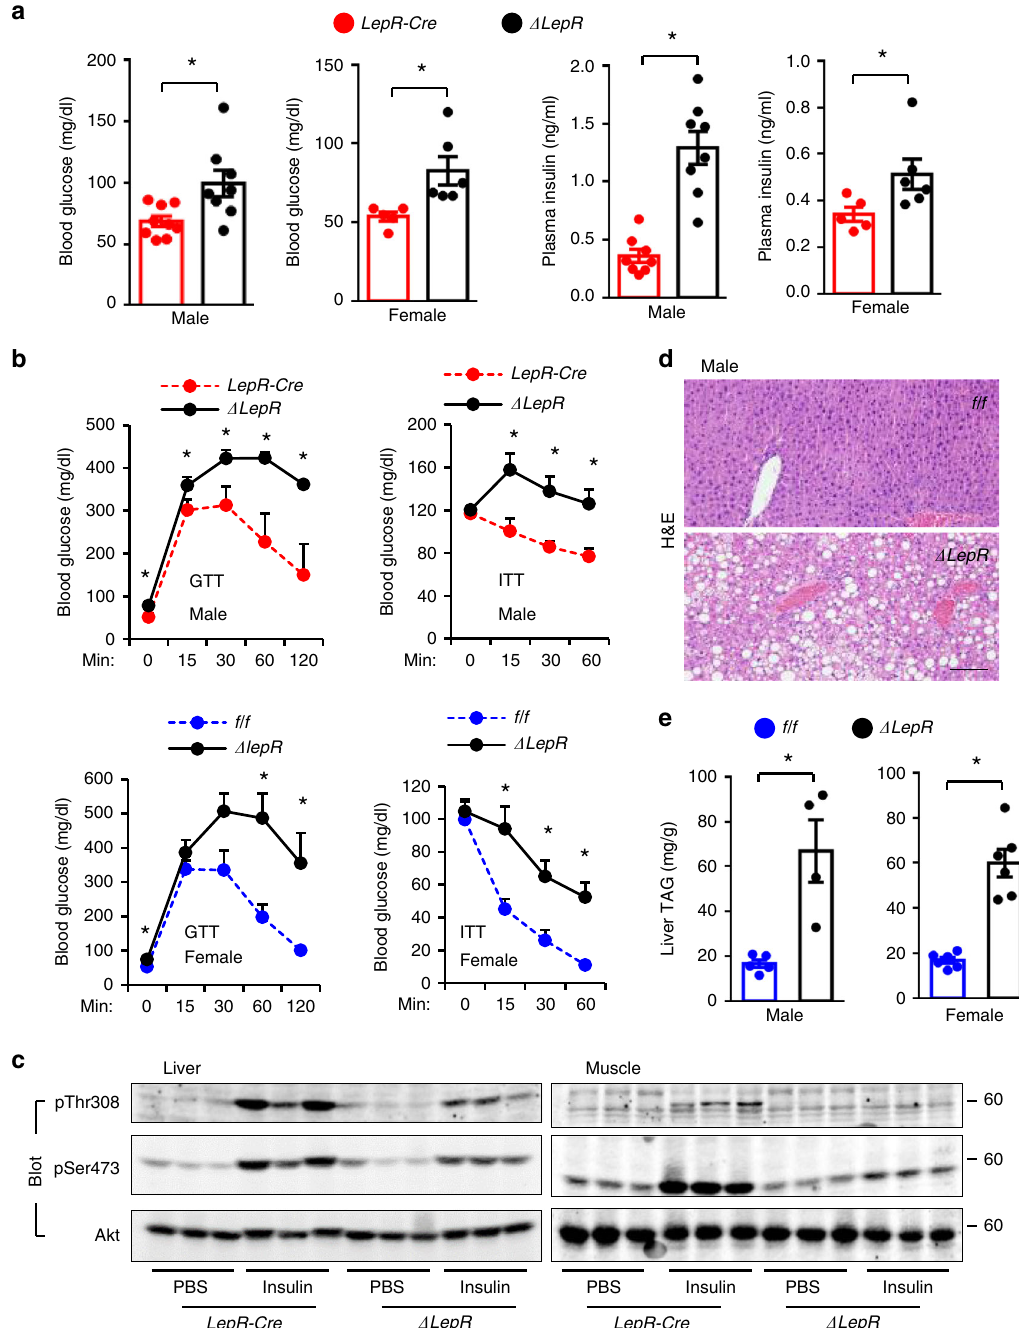
Fig. 2 Sh2b1 Δ LepR mice develop insulin resistance, glucose intolerance, and liver steatosis. a Overnight fasting blood glucose and insulin levels at 22 weeks of age. Male: LepR-Cre : n = 8 (insulin) and n = 9 (glucose), Sh2b1 Δ LepR : n = 8; female: LepR-Cre : n = 5, Sh2b1 Δ LepR : n = 6. b GTT and ITT at 20 weeks of age. Male: LepR-Cre : n = 9, Sh2b1 Δ LepR : n = 8; female: f/f : n = 5, Sh2b1 Δ LepR : n = 5. c Male mice (23 weeks) were stimulated with insulin. Liver and skeletal muscle extracts were immunoblotted with the indicated antibodies. Male: f/f : n = 6, Sh2b1 Δ LepR : n = 6; female: f/f : n = 6, Sh2b1 Δ LepR : n = 6. d Representative H&E staining of liver sections at 23 weeks of age (3 pairs). Scale bar: 200 μ m. e Liver TAG levels (normalized to liver weight) at 23 weeks of age. Male: f/f : n = 5, Sh2b1 Δ LepR : n = 4; female: f/f : n = 6, Sh2b1 Δ LepR : n = 6. Data are presented as mean ± SEM. * p < 0.05, two-tailed unpaired Student ’ s t -test. Source data are provided as a Source Data fi